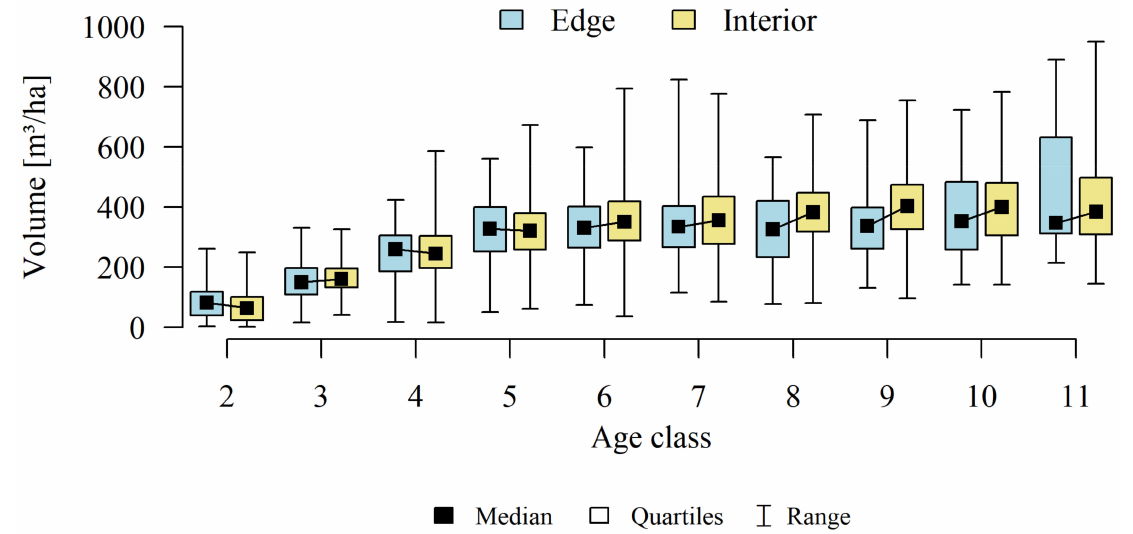
Figure 4. Results of statistics calculated for the growing stock volume density of pine stands on the FMCF site, divided into the edge and interior